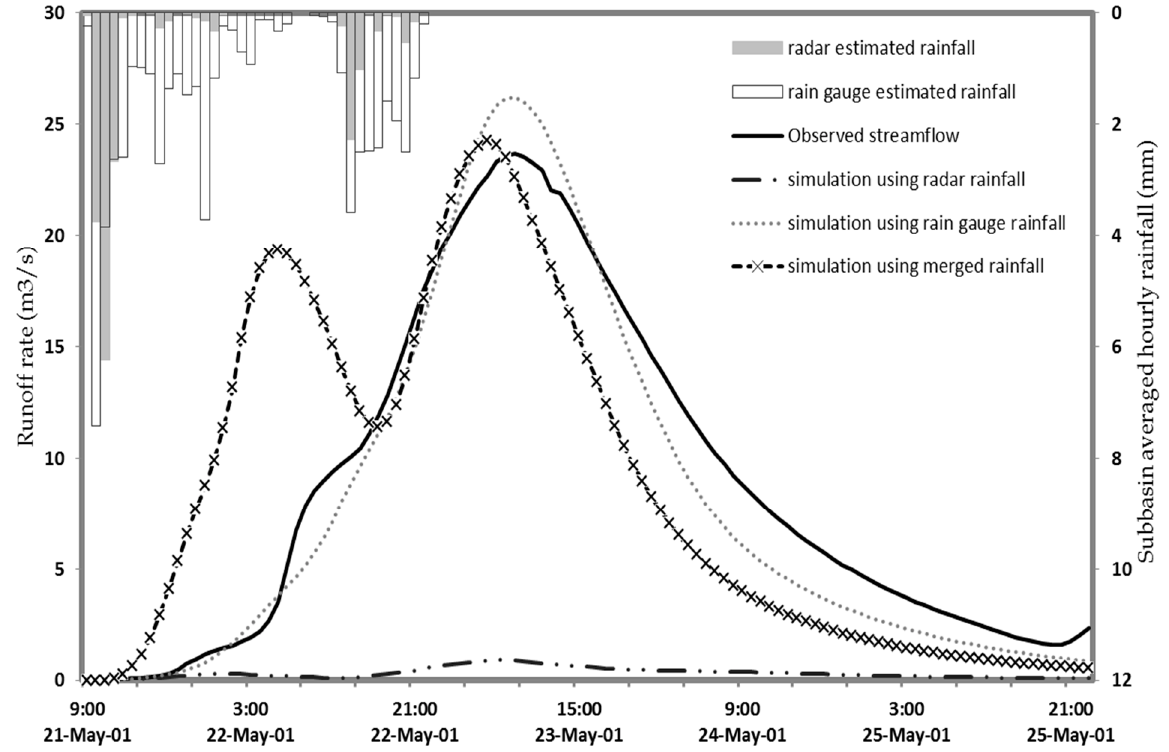
Figure 12. Comparison of estimated and observed hydrographs using different rainfall estimates for the 22 September 2000 event with SCS modeling option.